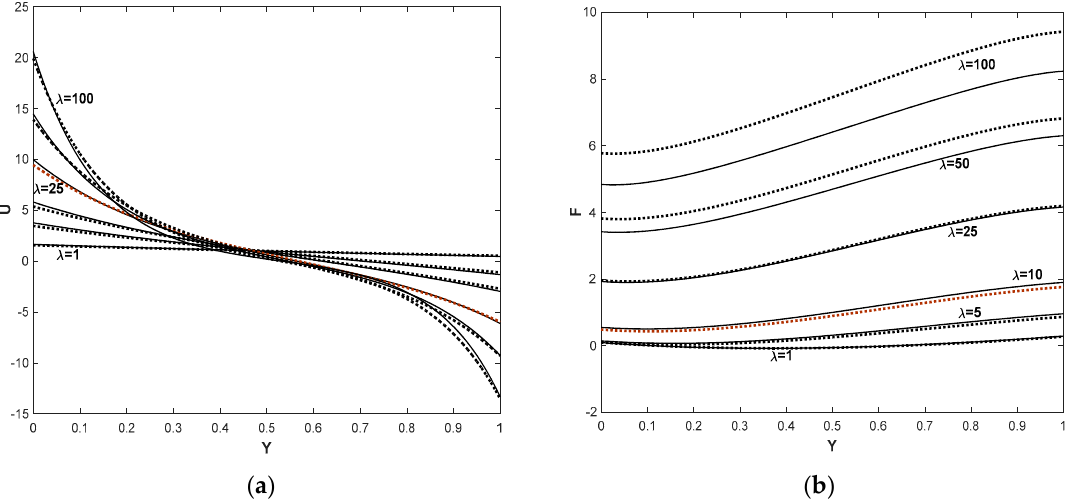
Figure 6. Velocity ( a ) and temperature ( b ) profiles, for Pe = 1, γ = π mixed-convection parameter λ , compared between simple nanofluid ( ϕ 2 = 0.0) plotted with a straight line and hybrid nanofluid ( ϕ 2 = 0.04 ) plotted with a dotted